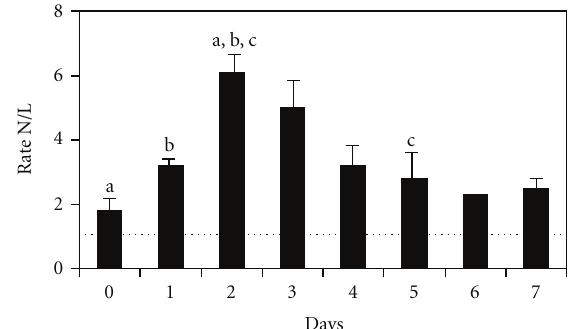
Figure 2: Mean ± standard error for the neutrophil/lymphocyte ratio (N/L) in patients with sudden deafness during the first week. Day 0 indicates the appearance of sudden deafness. The dotted line shows normal values. (Mann-Whitney U test. 0 versus 2: P = . 032. 1 versus 2: P = . 005. 2 versus 5: P = .